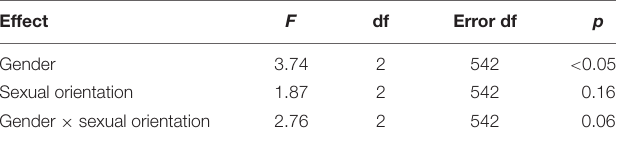
TABLE 5 | MANOVA multivariate test of the effects on the SPQ.